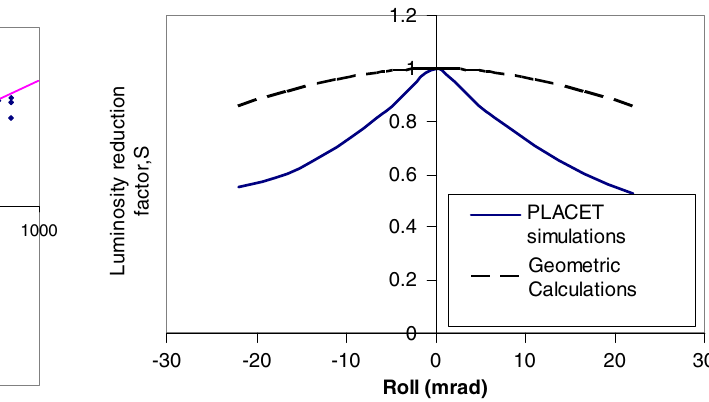
FIG. 3. (Color) The horizontal offset against longitudinal posi- tion for the macroparticles in a bunch at the IP of the ILC.